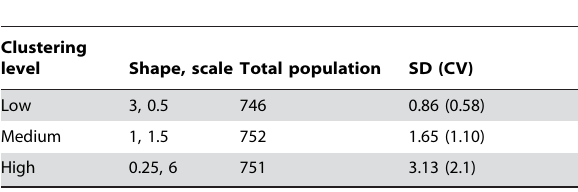
Table 3. Characteristics of simulated